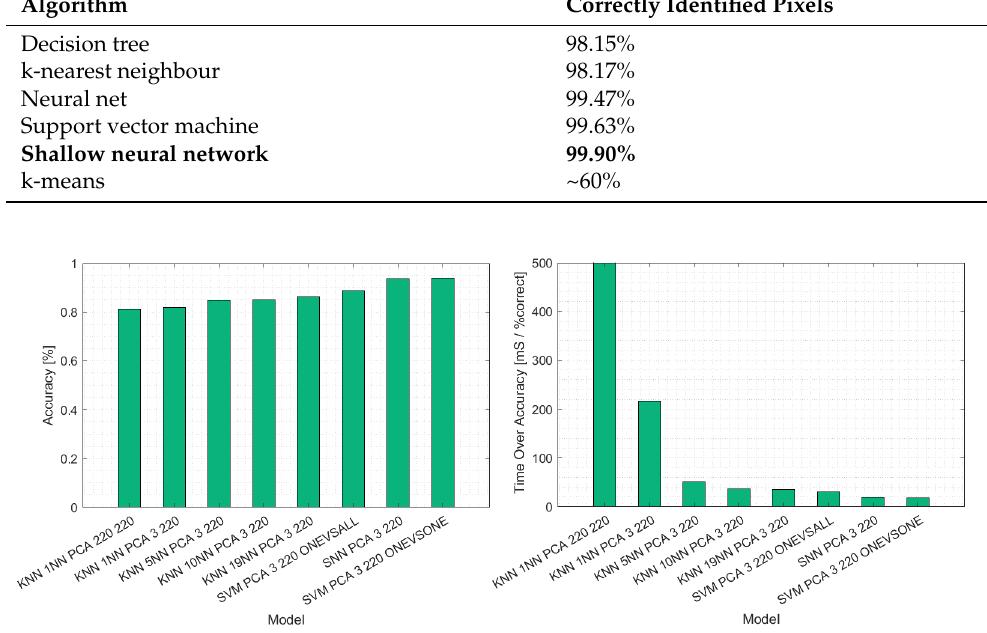
Figure 22. Comparison of the different machine learning algorithms used for classifying monolayer and multilayer materials in the test